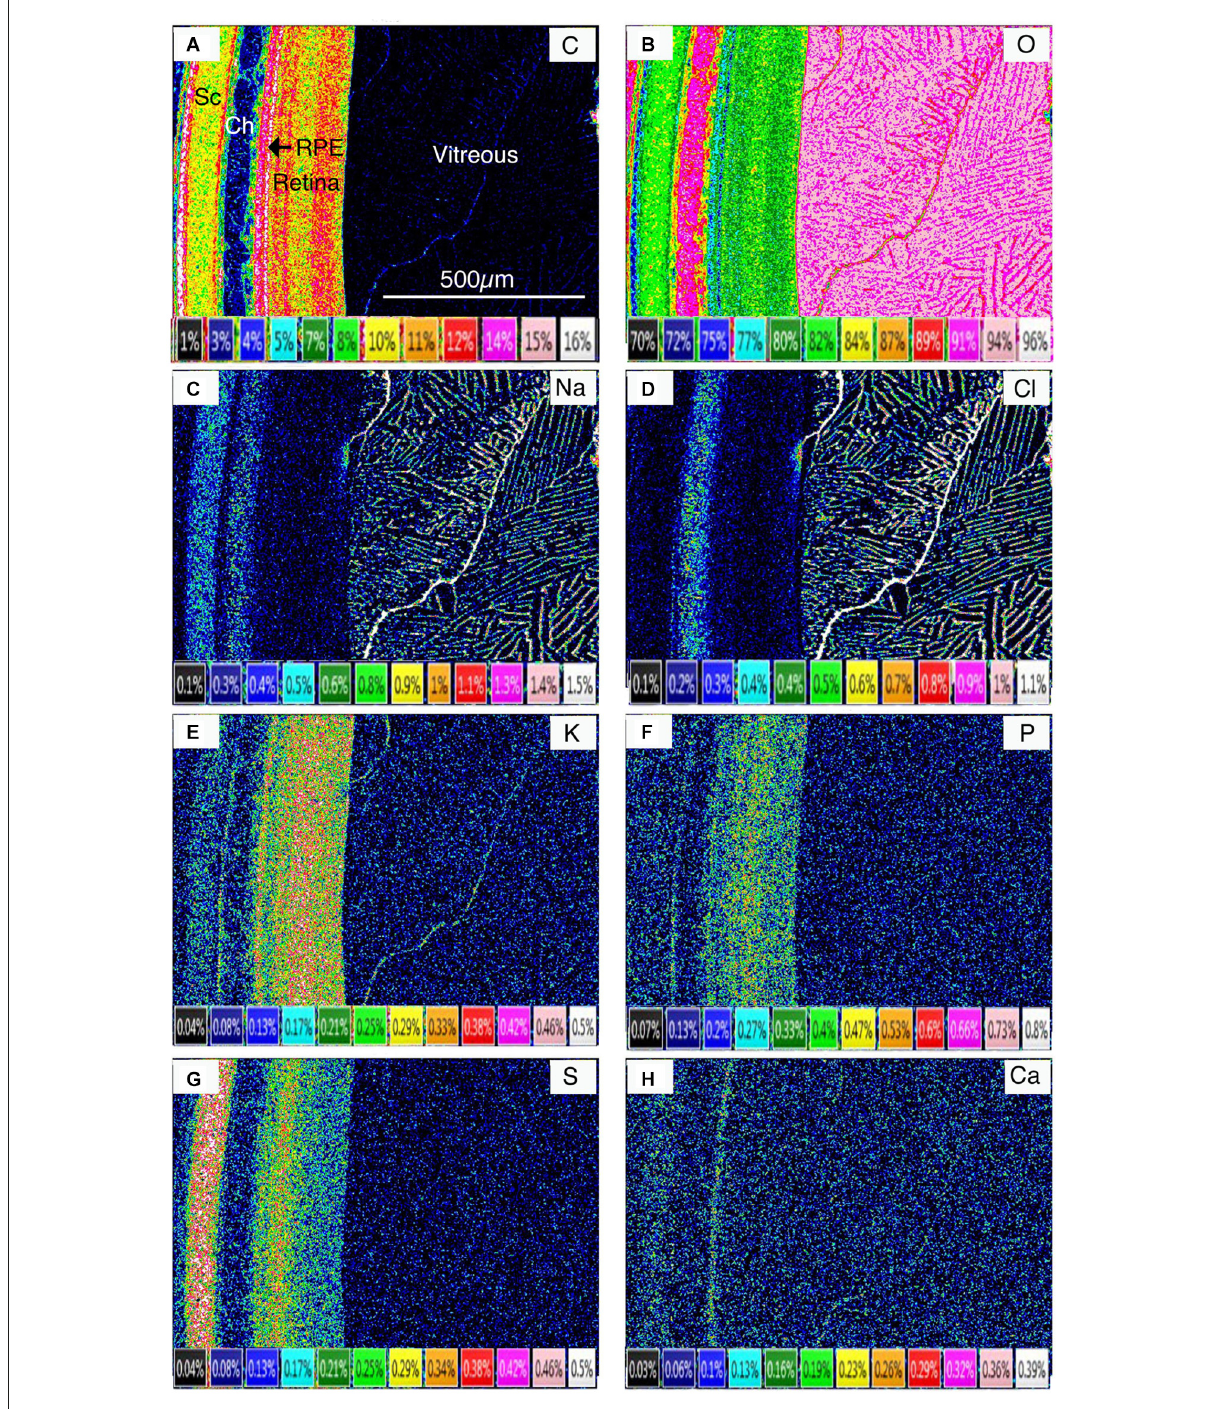
FIGURE2 Quantitative elemental concentration images in weight percent of frozen-hydrated chick eye. Sc, sclera; Ch, choroid; RPE, retinal pigment epithelium. (A) Carbon (C). (B) Oxygen (O). (C) Sodium (Na). (D) Chlorine (Cl). (E) Potassium (K). (F) Phosphorus (P). (G) Sulfur (S). (H) Calcium